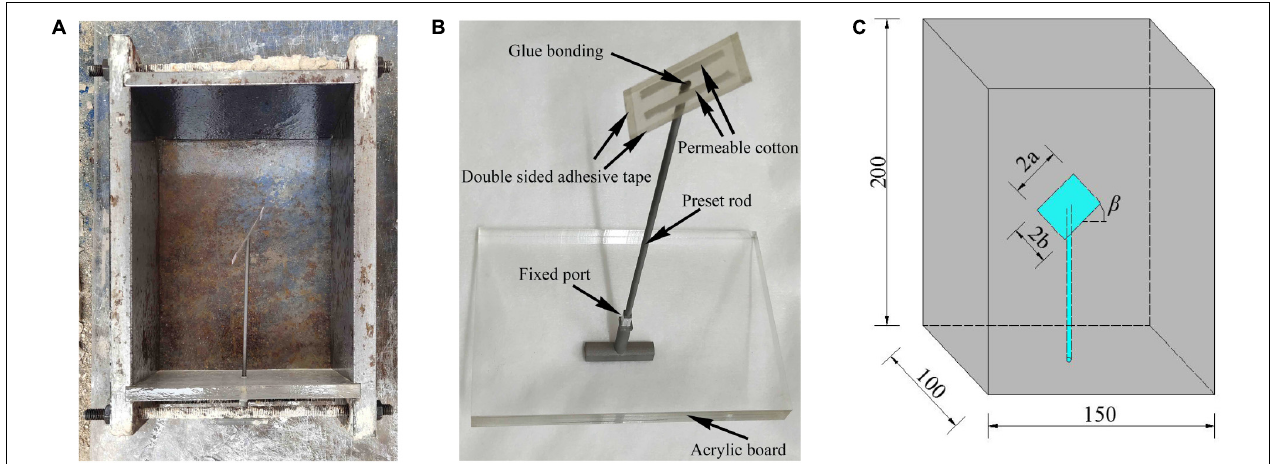
FIGURE 7 | Schematic diagram showing the formation of an internal fracture specimen: (A) image of the mold; (B) image of the support; and (C) schematic diagram of the resulting specimen (unit: mm).